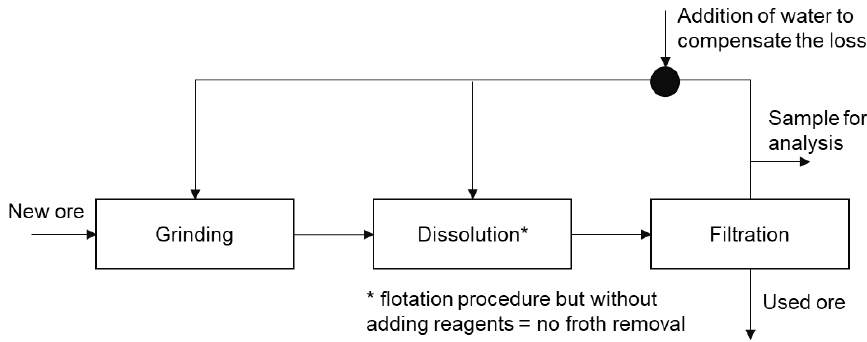
Figure 2. Overview of the dissolution test procedure.